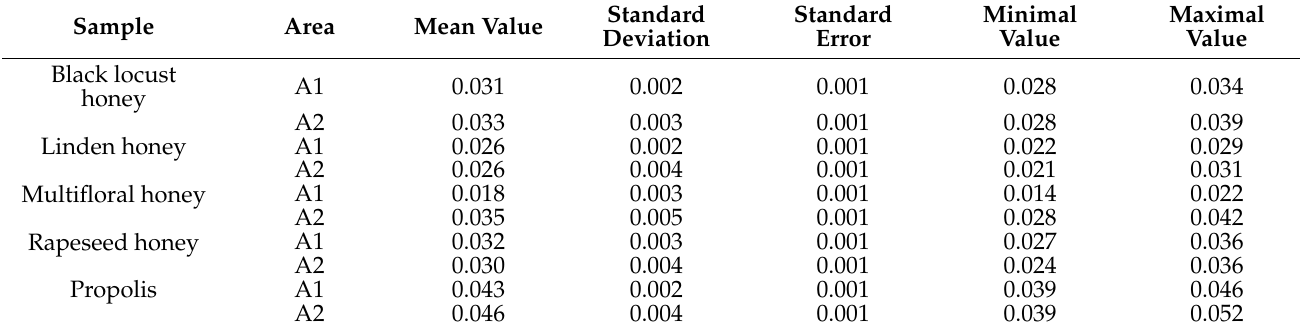
Table 11. Bioconcentration factor for Ni.